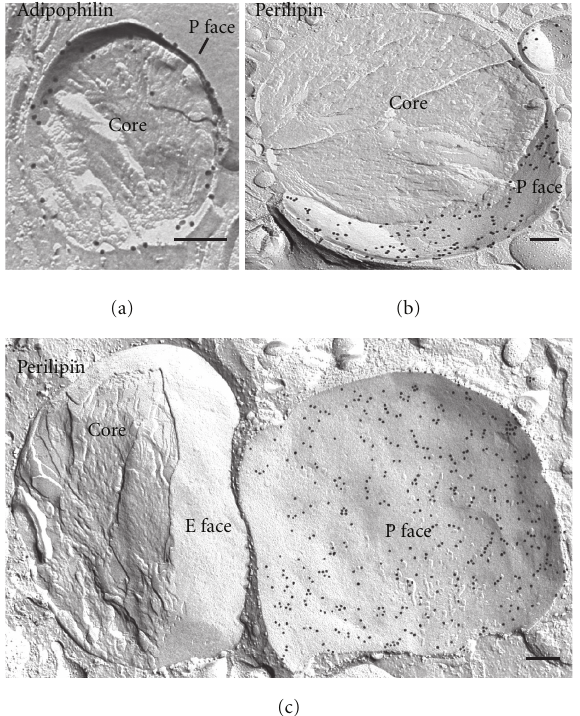
Figure 3: FRIL demonstrates the presence of adipophilin and perilipin in lipid droplets. Examples in which adipophilin (a) and perilipin (b) label is seen in the outer phospholipid monolayers (P face) of the lipid droplet. The example in (c) illustrates a convexly and a concavely fractured lipid droplet. Perilipin is localized in the P face of the lipid droplet monolayer, whereas the E face is completely devoid of label. ((a) from a lipid-laden macrophage; (b) and (c) from lipid-laden adipocytes). Bars: 0.2 μ m.